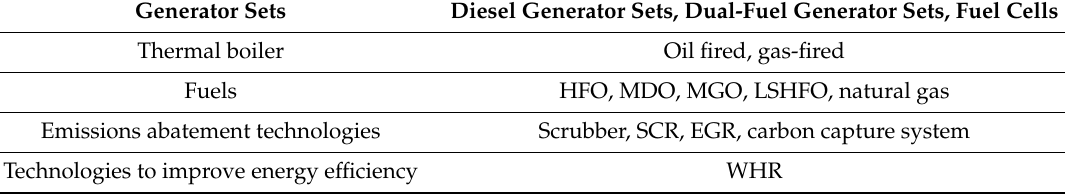
Table 4. Technologies considered for the cruise